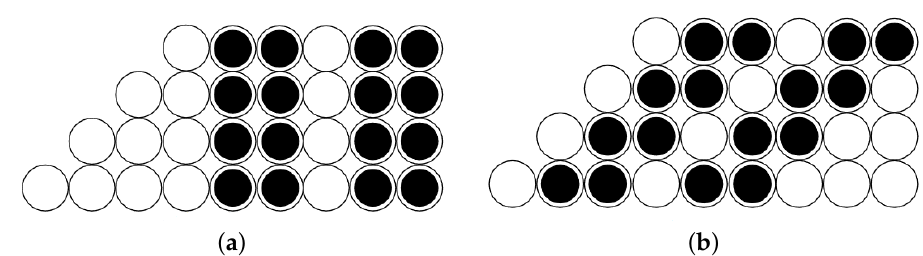
Figure 18. The corresponding triangular sequences come from counting blocks. ( a ) Vertical roots. ( b ) Diagonal